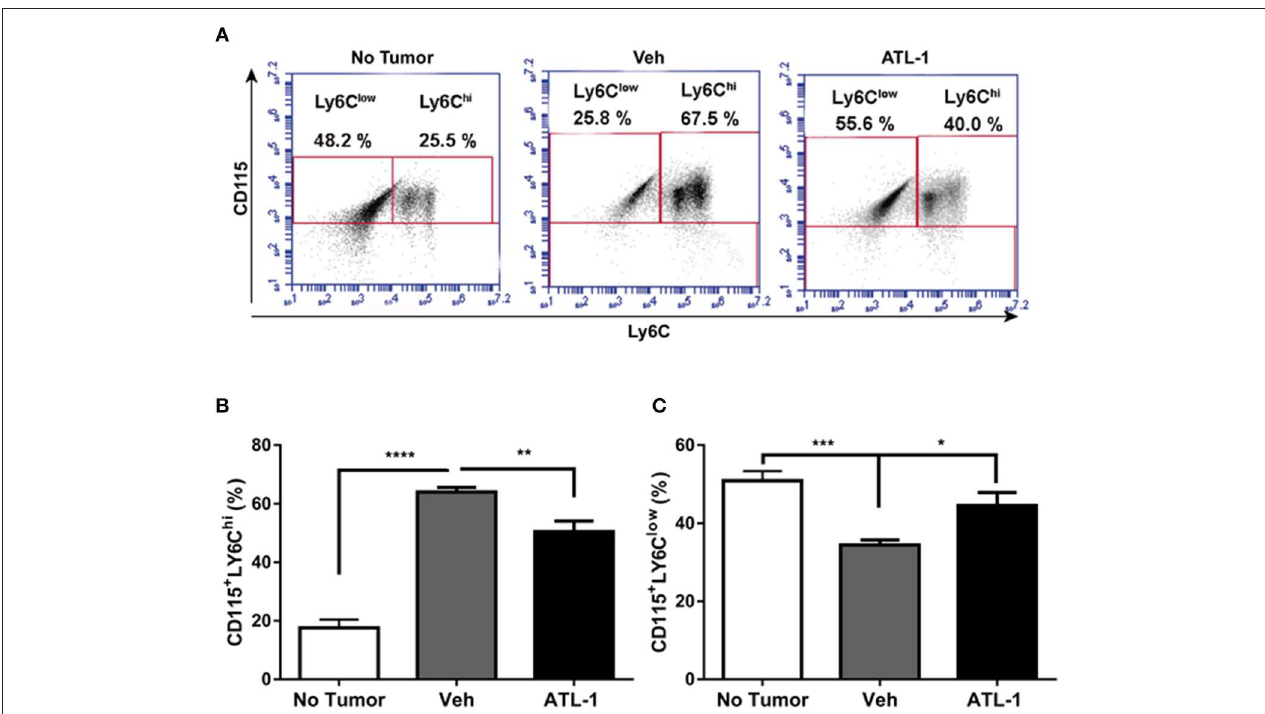
FIGURE 2 | ATL-1 treatment decreases CD115 + LY6C hi cell population in bone marrow of tumor-bearing mice. C57/BL6 mice were inoculated with B16/F10 tumor cells. After 14 days, ATL-1 (1 µ g/animal) or vehicle (20 µ L ethanol) was administered. On 21st day, the animals were sacrificed, the femurs and tibias dissected, and the bone marrow cells isolated for further analysis by flow cytometry. (A) Representative dot plot used to quantify the percentage of CD115 + /LY6C hi and CD115 + /LY6C low populations within the selected gate. (B) CD115 + LY6C hi ( n = 7); (C) CD115 + LY6C low ( n = 7). Data are expressed as mean ± SEM. * p < 0.05 ; ** p < 0.01 ; *** p < 0.001 ; **** p < 0.0001 by unpaired t -test or ANOVA test, followed by Bonferroni